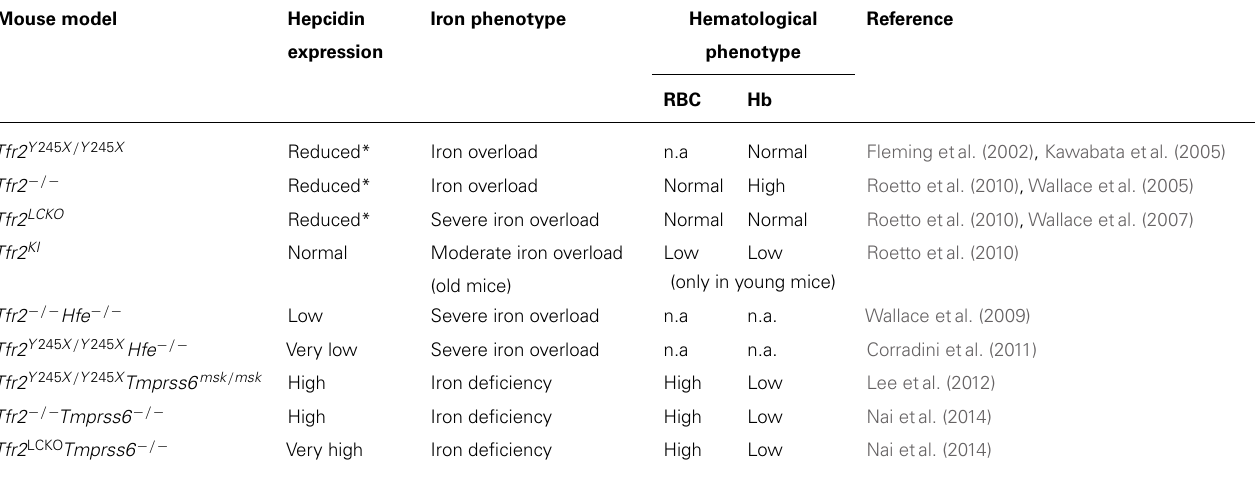
Table 1 | Hepcidin levels, iron and hematological phenotype in the available murine models of Tfr2 inactivation. Mouse